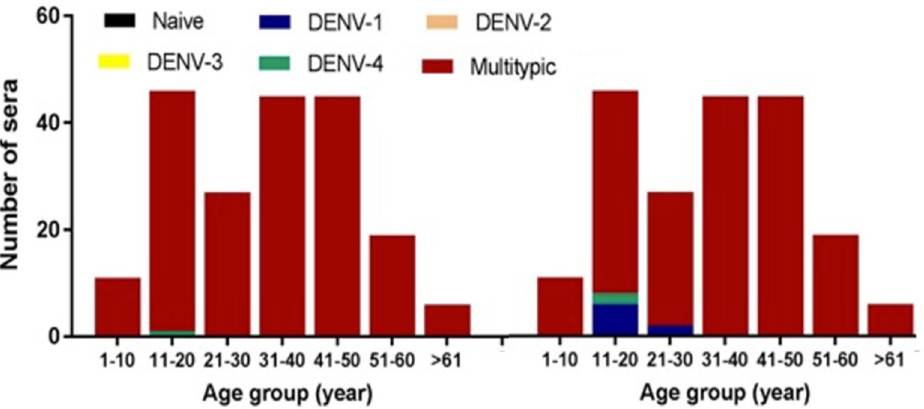
Figure 2. Status of DENV infection by age group ( n = 199). Status of individuals with naïve, monotypic, or multitypic infections classified using two thresholds (PRNT 50 and PRNT 90 at >10). For each threshold, all monotypic infections were observed in individuals younger than 30 years old.